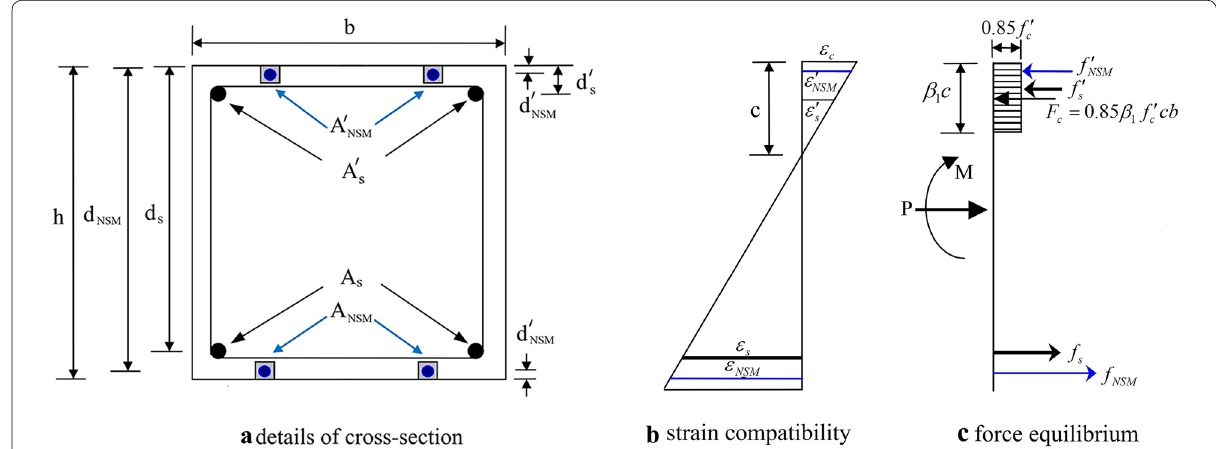
Fig. 11 Distribution of strains and stresses for RC column strengthened with NSM FRP bars: a section configuration; b strain compatibility; c force